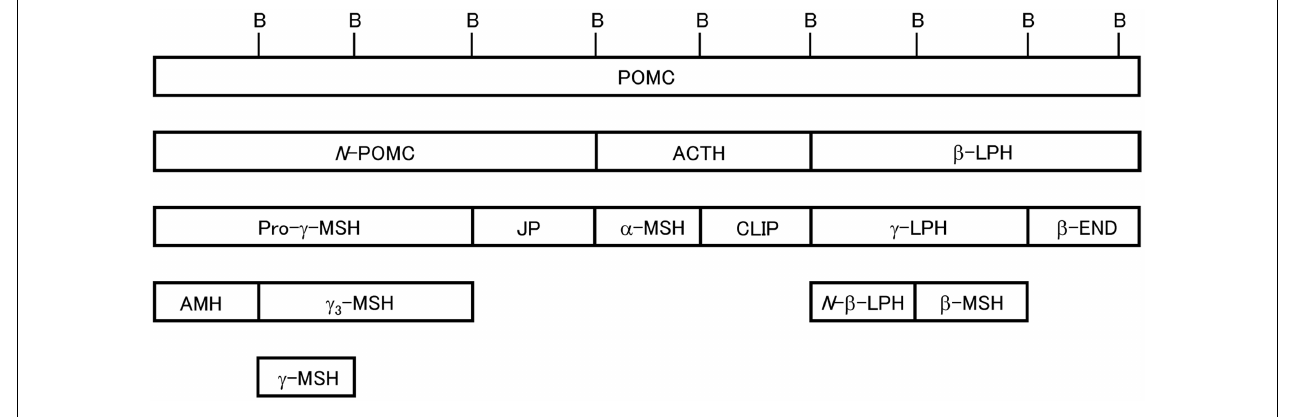
FIGURE 1 | Schematic of 3MSH/1END type POMC [modified from Ref. (24)] . Relative positions of the peptide segments are shown. Peptide terminology modified from Eberle (4). B, dibasic sequences that partition the